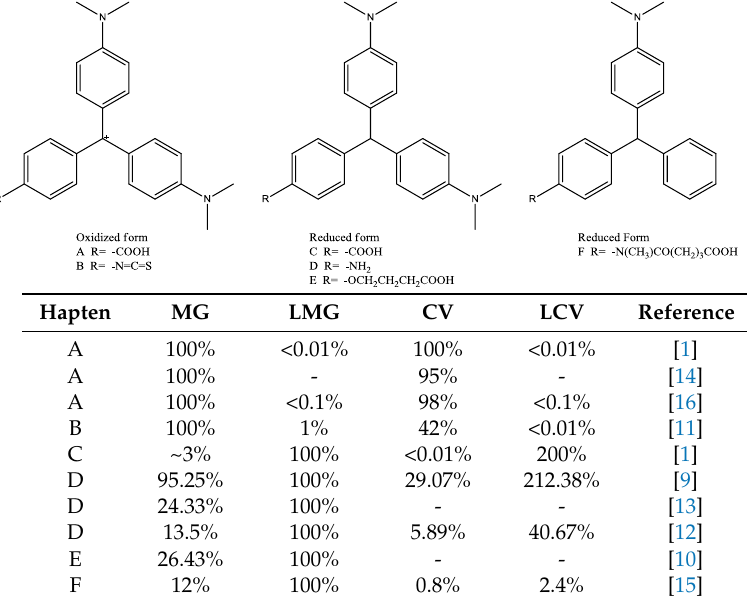
Table 1. Structures and cross-reactivity ratios of reported haptens with MG, LMG, CV, and LCV.